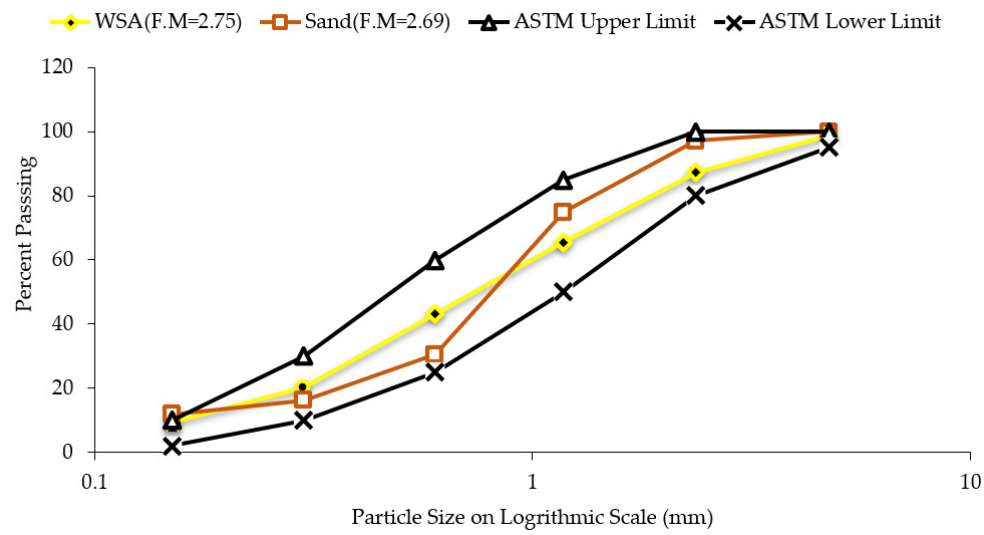
Table 1. Relative density, water absorption of sand, WSA, and coarse aggregate. Sand